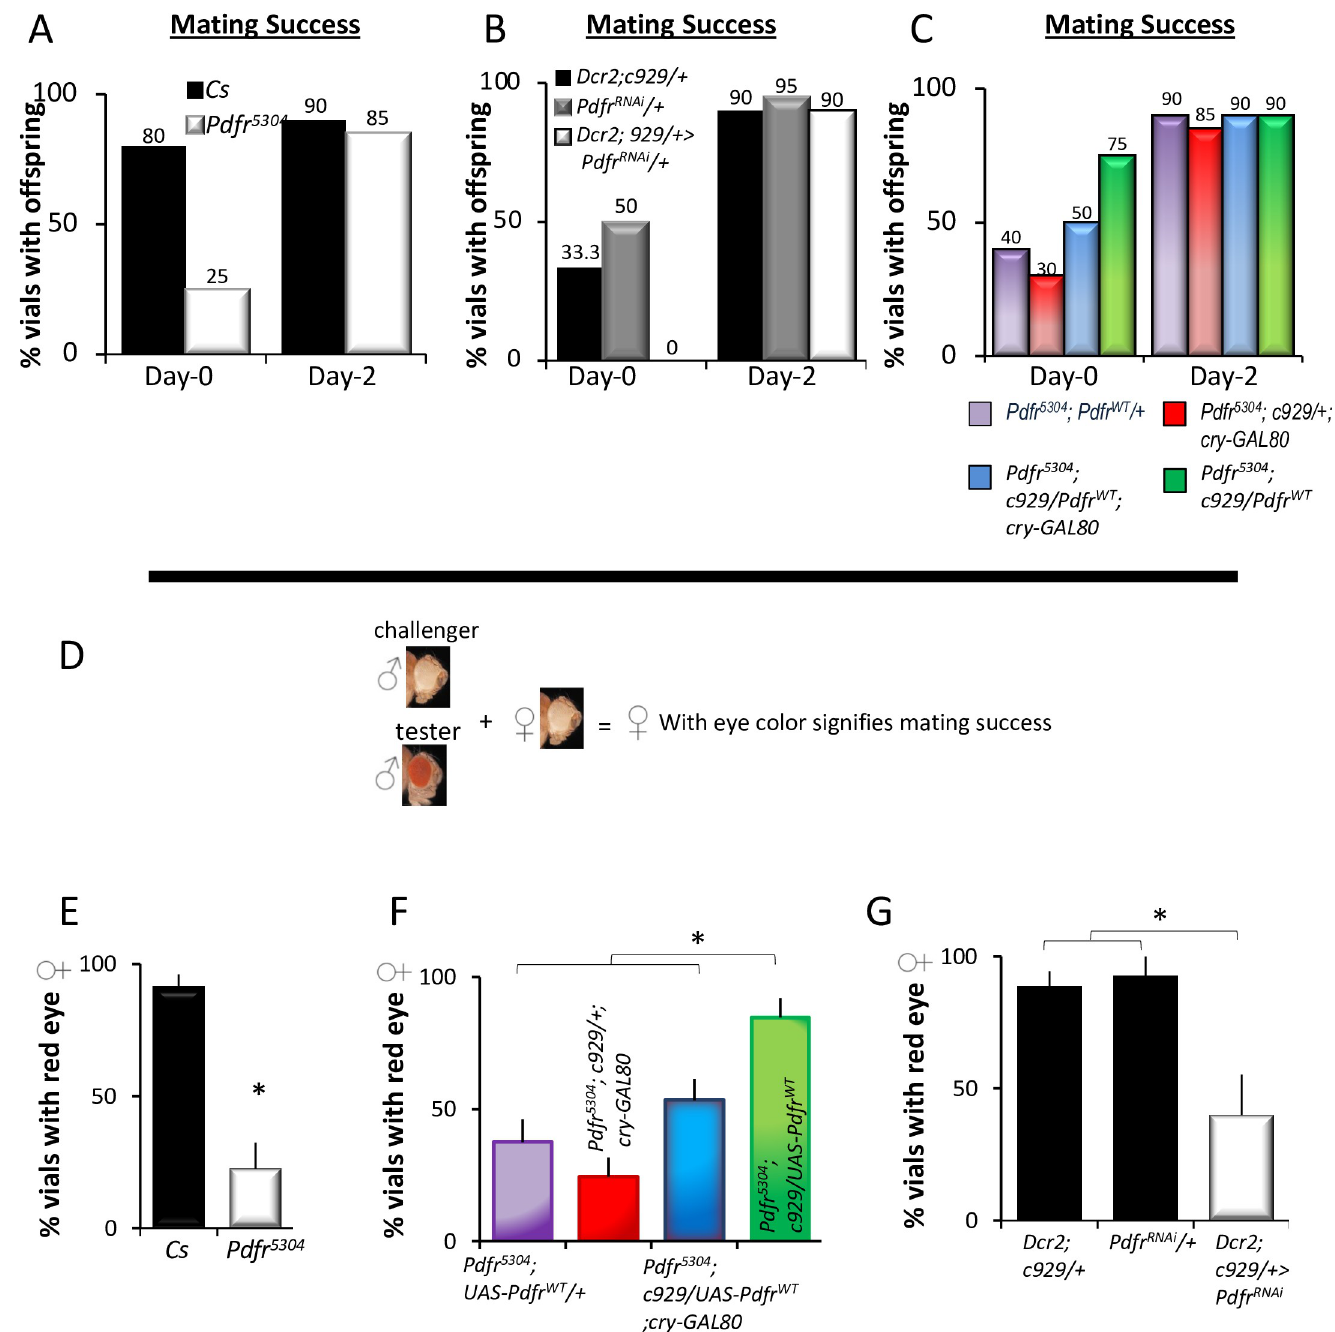
Fig 3. Role for PDFR in l-LNvs in mating success. (A) Cs flies produce more offspring than Pdfr 5504 mutants ( n = 30/genotype); χ 2 = 12.13, p = 0.0004. (B) Dcr2; c929- GAL4/UAS- Pdfr RNAi flies produce fewer vials with offspring compared to Dcr2; c929- GAL4/ + and +/UAS- Pdfr RNAi parental controls; ( n = 30/genotype); χ 2 = 21.3, p = 0.00002 (C) Pdfr 5504 ; c92- GAL4; UAS- Pdfr WT (rescue, green) flies produce more offspring than Pdfr 5504 ; UAS- Pdfr WT /+ (purple), Pdfr 5504 ; c929-GAL4/+; CryGal80/+ (red), and Pdfr 5504 ; c929- GAL4/UAS- Pdfr ; Cry- Gal80 (blue) parental controls ( n = 30/genotype) χ 2 = 8.95, p = 0.029. (D) Mating competition assay scheme on day 1. (E) Cs males outcompeted white-eyed challenger flies compared to Pdfr 5504 mutants ( t test, p < 0.001, n = 3 sets of 20 flies/genotype). (F) Pdfr 5504 ; c929-GAL4/+; UAS-Pdfr/+ males outcompeted white-eyed challengers compared to Pdfr 5504 ; UAS-Pdfr , Pdfr 5504 /+; c929-GAL4/+; Cry-Gal80/+ , or Pdfr 5504 ; c929-GAL4 /UAS- Pdfr ; Cry-Gal80 /+ controls (ANOVA F [3,13] = 15.01, p = 4.9 − 4 ; n = 3 sets of 20 flies/line). (G) Dcr2; c929-GAL4 / UAS-Pdfr RNAi flies displayed reduced mating success compared to Dcr2; c929-GAL4 / + and +/ UAS-Pdfr RNAi control flies (ANOVA, F [2,8] = 8.10, p = 0.019, n = 43–55). � p < 0.05, modified Bonferroni test. Data underlying this figure can be found in S3 Data. l-LNv, large ventral lateral neuron; PDFR, pigment dispersing factor receptor; RNAi, RNA interference.